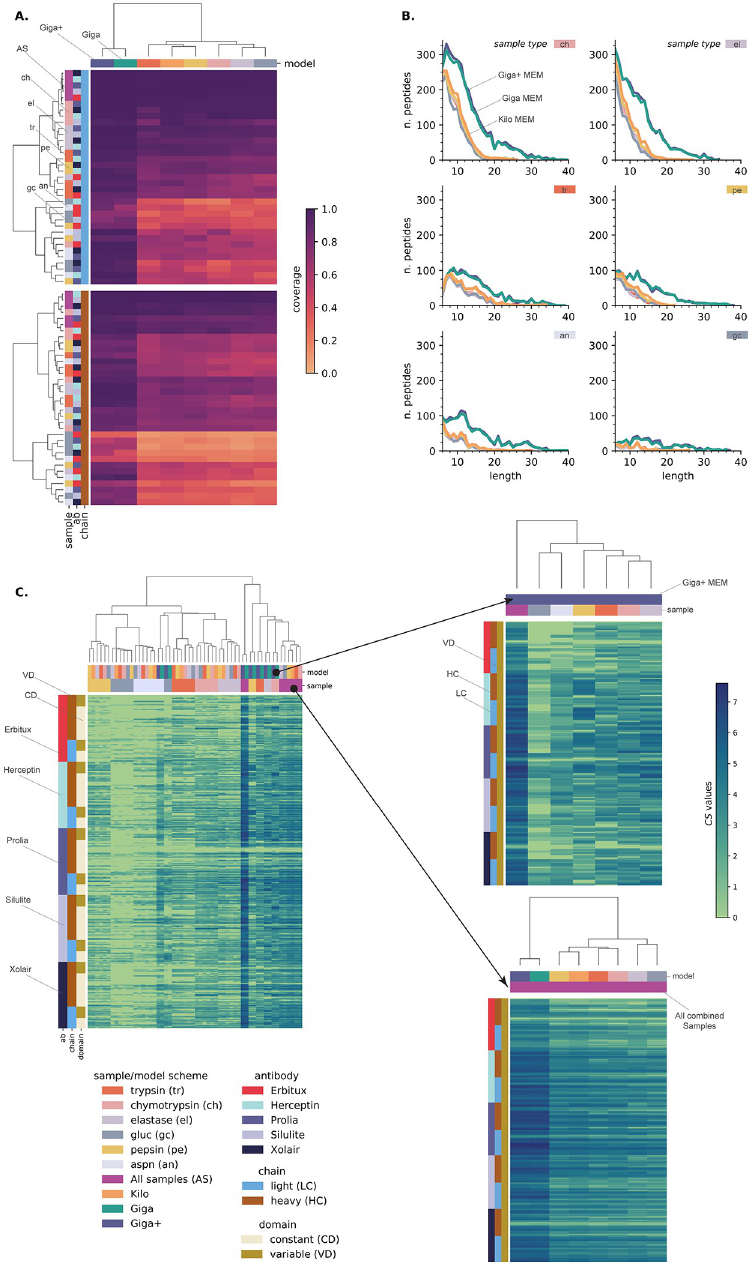
Fig 7. Complete de novo sequencing of commercial monoclonal antibodies by deep learning models. A) coverage of all the light ( top ) and heavy ( bottom ) chains for all types of samples. B) length distribution for all matching peptides extracted from each type of sample; C) Confident positional score (CS) values for all proteins’ variable and constant domains. General view of CS values for the evaluated models on all sample types ( Left panel ). Zoom into the CS values for the heavy and light chains variable domains for the Giga+ deep learning model across all sample types ( Right top panel ) and all models when combining all sample types ( Right bottom panel